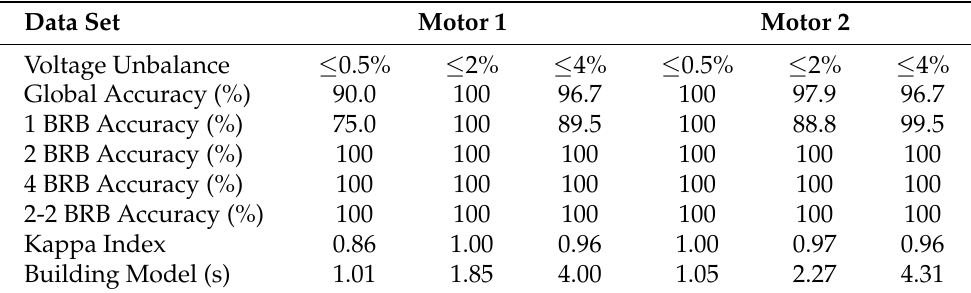
Table 8. Experimental results using the 450 SMI attributes among i a , i b and i c —Severity analysis of rotor